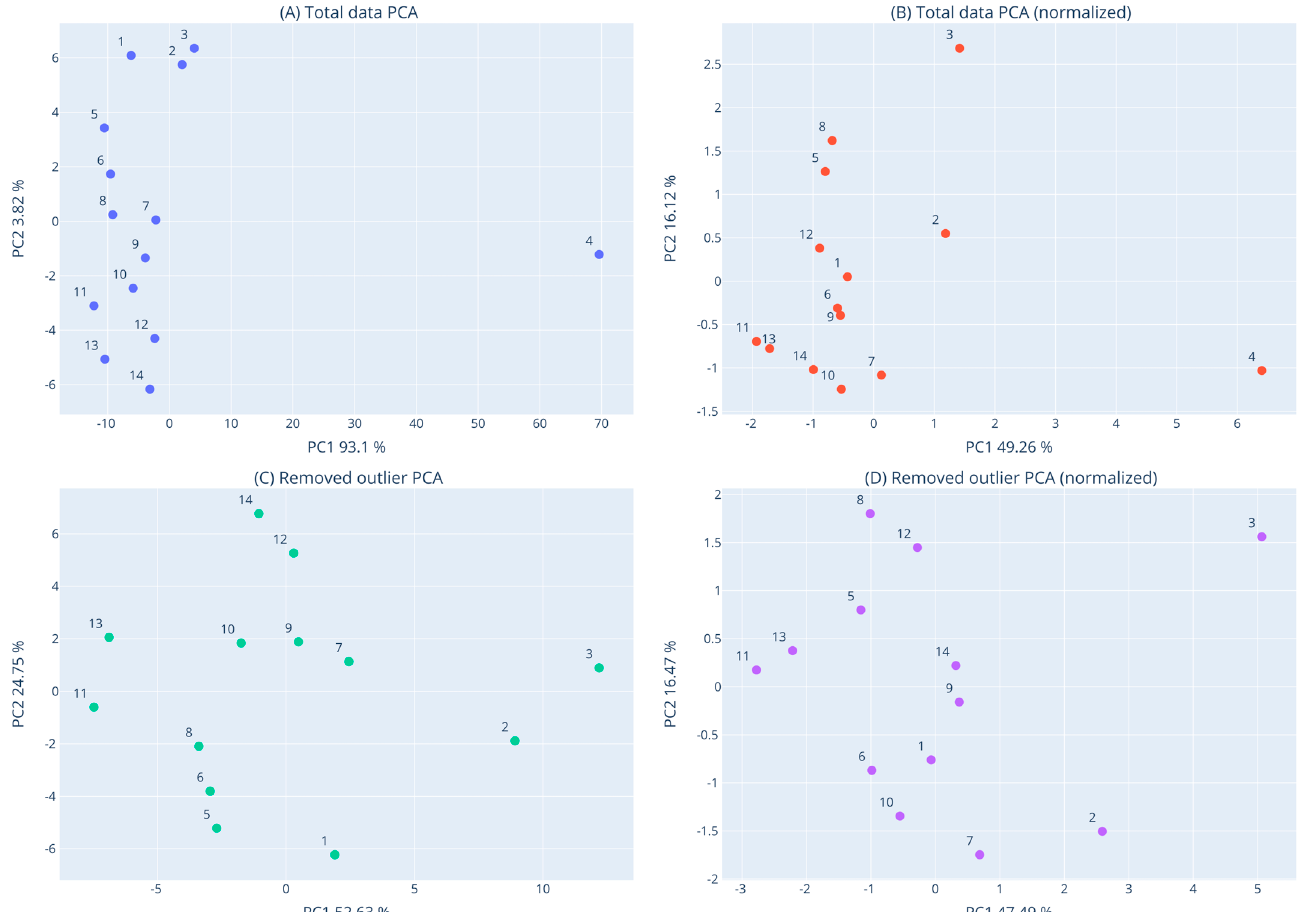
Figure 8. Principal component analysis (PCA) of the samples based on the 7 bioactivity metrics. The fi rst 3 principal components are computed for each graph. Each dot represents one sample, and the number above it indicates the sample index. ( A ) PCA of all the 14 samples based on raw measurements. ( B ) PCA of the 14 sample, after Z-score normalization. ( C ) PCA of the 13 samples based on raw measurements after removing the outlier ( C. fragile ). ( D ) PCA of the Z-score normalized data after removing the outlier ( C. fragile ). The indexes of the various samples correspond to: 1: U. rigida , 2: G. gracilis , 3: C. sinuosa , 4: C. fragile , 5: C. barbata , 6: C. amentacea , 7: U. intestinalis , 8: C. compressa , 9: S. vulgare , 10: P. pavonica , 11: G. teedei , 12: G . sp., 13: G. pistillata , 14: G. bursa pastoris